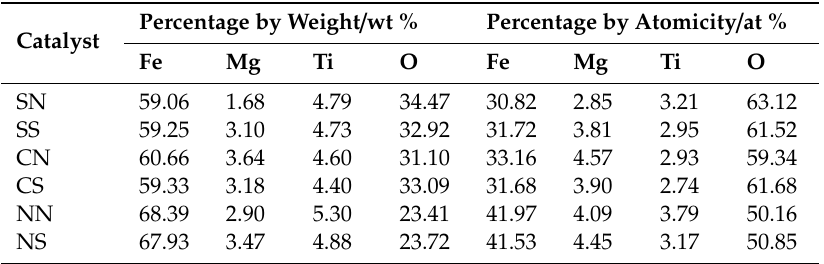
Table4. EDScompositionanalysisdataoftitaniummodifiedFeMgO x catalystswithdi ff erentprecursors.